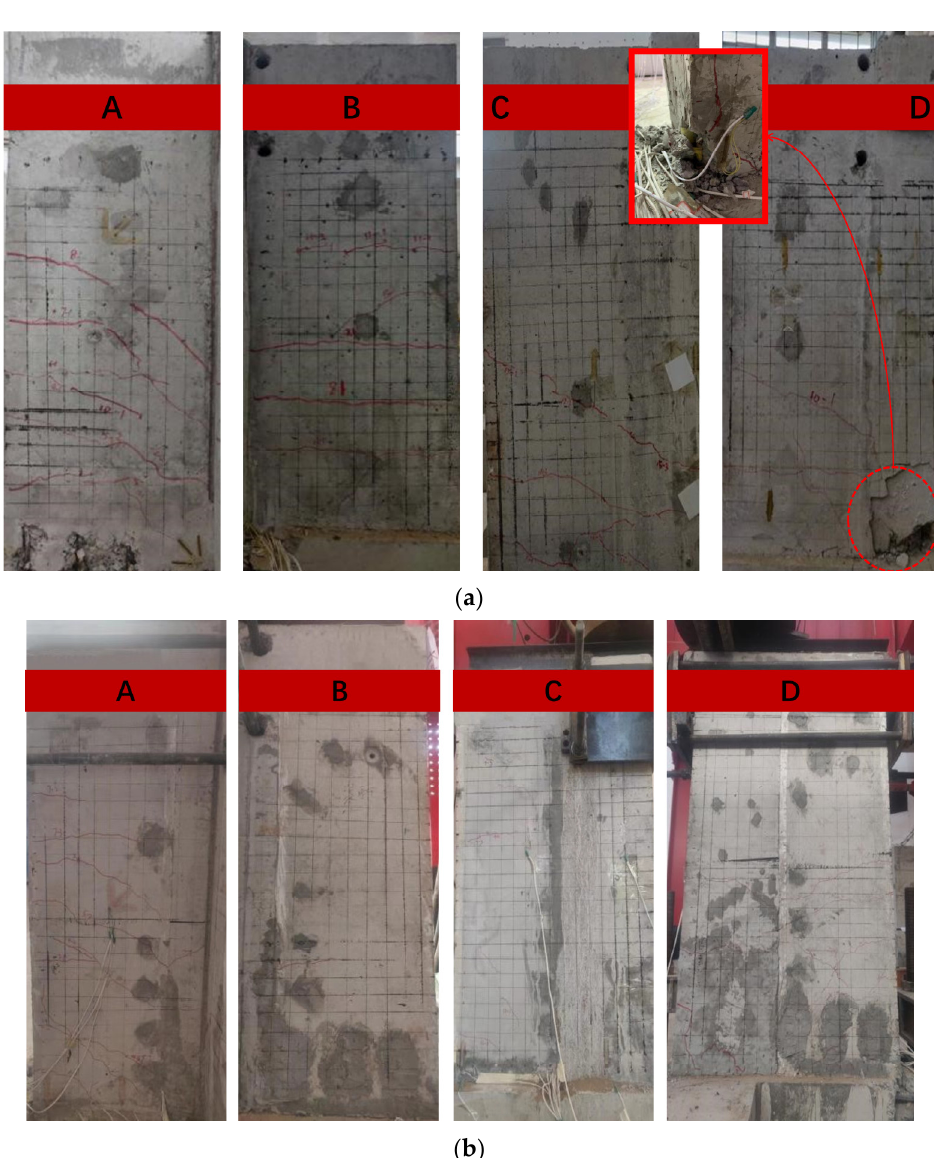
Figure 7. The failure model of the specimens. ( a ) The failure model of specimen L−1. ( b ) The failure model of specimen TL−1.